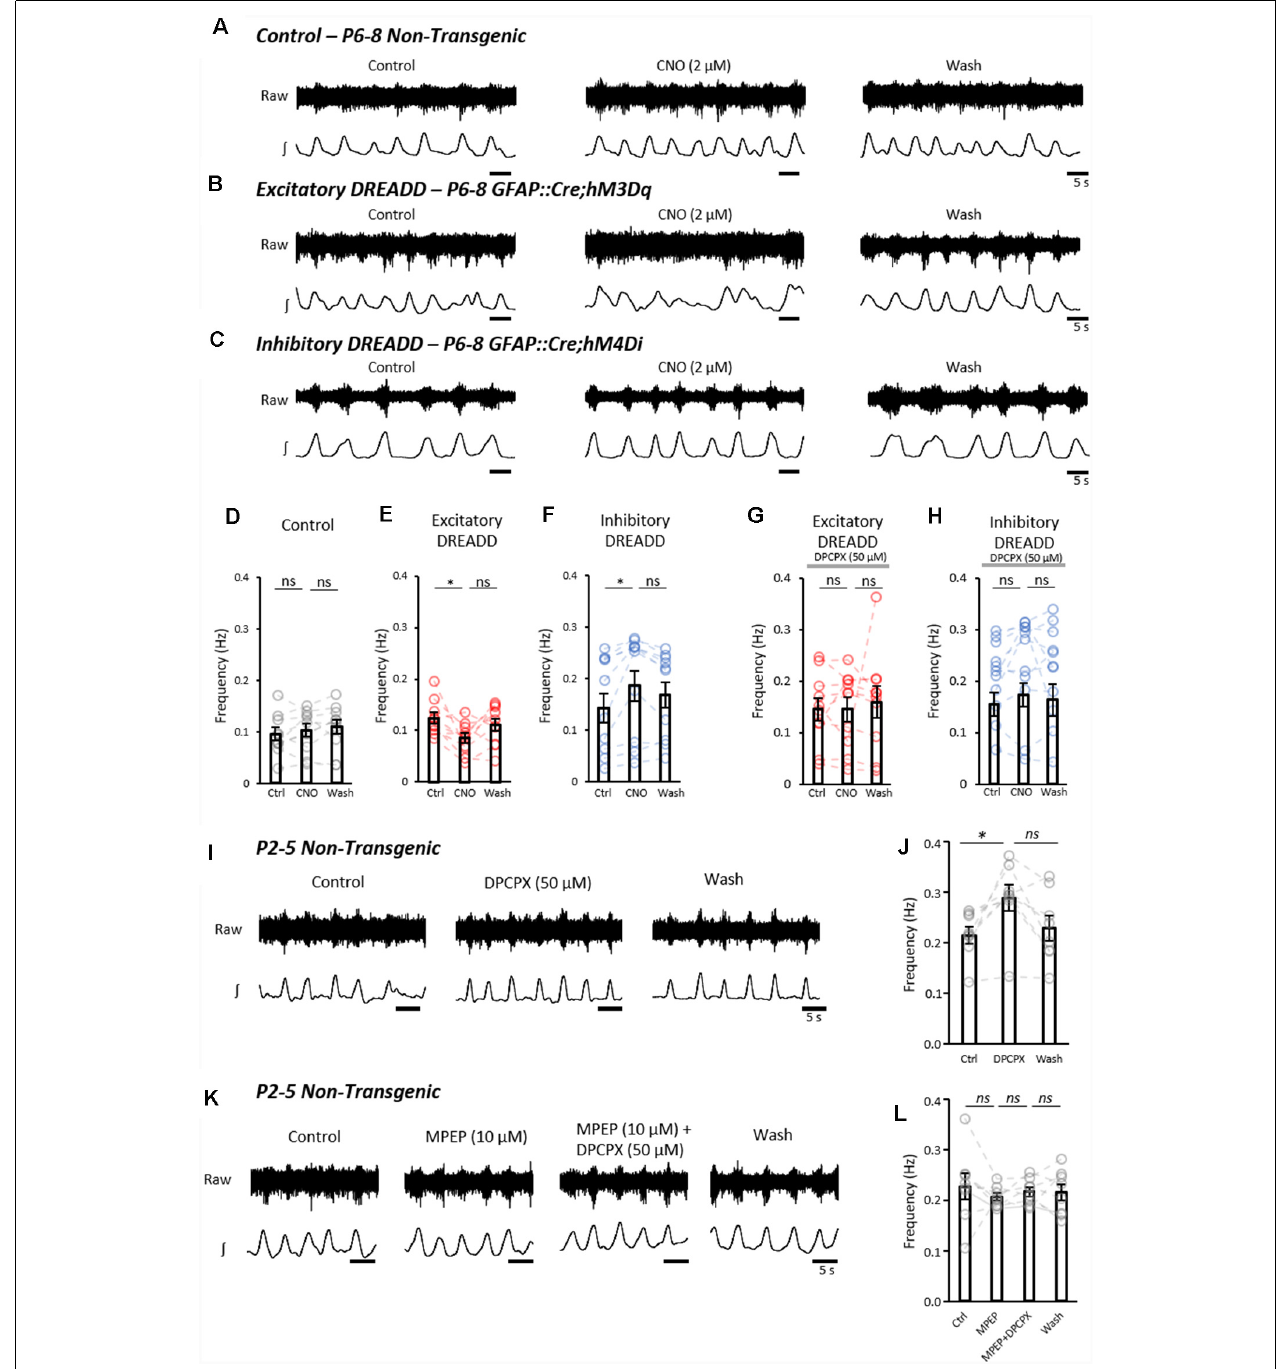
FIGURE 4 | Astrocytes exert purinergic modulation of locomotion in response to mGluR5 dependent activation. (A) Example raw (top) and rectified/integrated (bottom) traces of pharmacologically induced fictive locomotor bursts recorded from in vitro spinal cord preparations from control non-transgenic neonatal mice. The burst frequency, duration and amplitude were analyzed in control conditions, in the presence of CNO and following the washout of CNO. (B) Pharmacologically induced fictive locomotor bursts recorded from a GFAP::cre;hM3Dq (excitatory DREADD) neonatal mouse spinal cord in vitro during control conditions, in the presence of CNO and following the washout of CNO. (C) Pharmacologically induced fictive locomotor bursts recorded from a GFAP::cre;hM4Di (inhibitory DREADD) neonatal mouse spinal cord in vitro during control conditions, in the presence of CNO and following the washout of CNO. (D) Bar chart displaying the frequency of fictive locomotor bursts in control, non-transgenic mouse spinal cords in response to CNO. (E) Bar chart displaying the frequency of fictive locomotor bursts in excitatory DREADD mouse spinal cords in response to CNO. (F) Bar chart displaying the frequency of fictive locomotor bursts in inhibitory